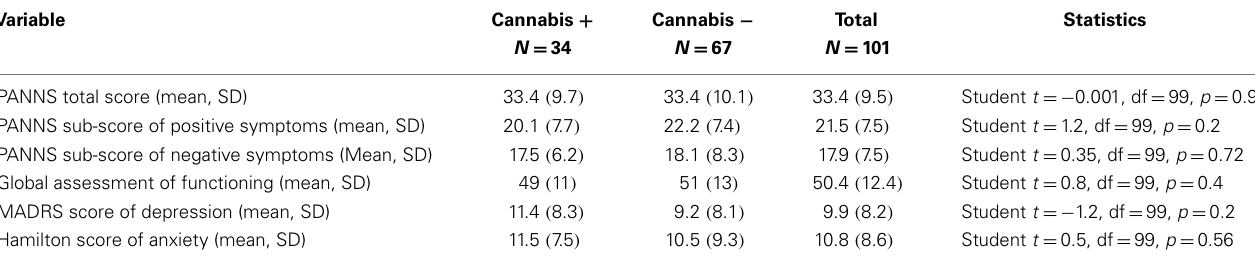
Table 3 | Comparison of psychiatric symptoms among schizophrenic patients with and without cannabis consumption .